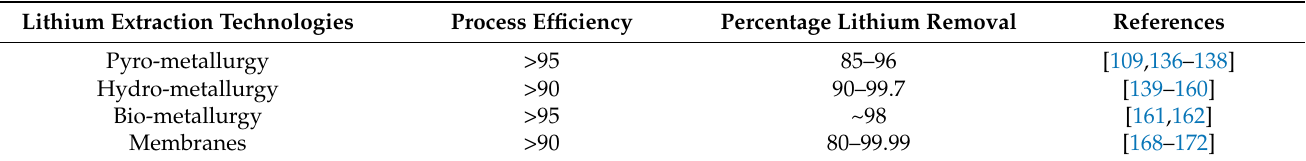
Table 3. A comparison of the process efficiency and percentage lithium recovery in lithium ion battery based